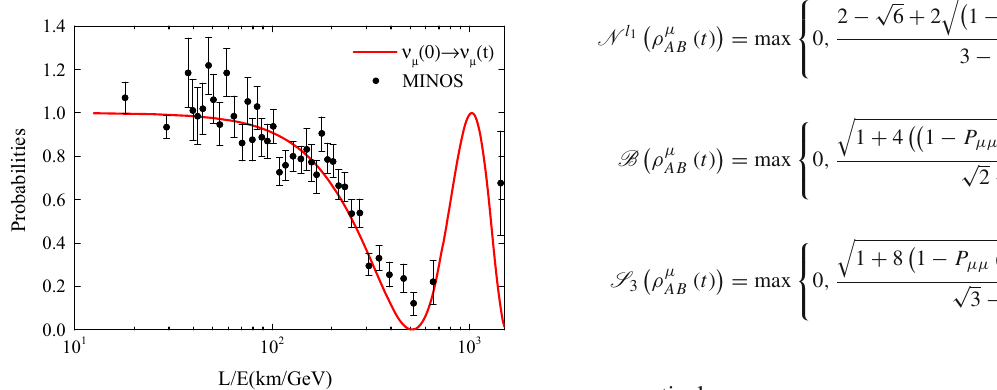
(cid:11) (cid:11) (cid:11) (cid:11) 2 a μμ ( t ) and the oscillation probability (cid:11) (cid:11) (cid:11) (cid:11) 2 a μ e ( t ) , respec-